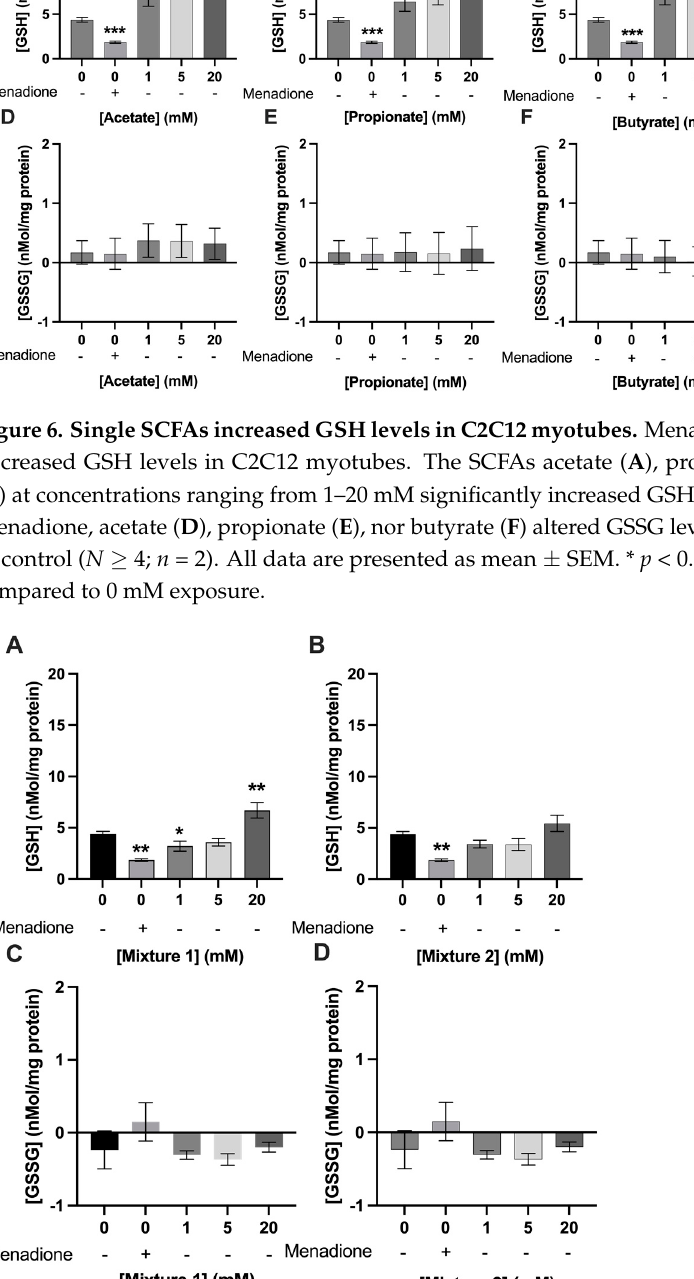
Figure 7. 20 mM of mixture 1 increased GSH levels while 1 mM decreased GSH in C2C12 myo ‐ tubes. Menadione (25 μ M) significantly decreased GSH levels in C2C12 myotubes. Twenty four hours of exposure to mixture 1 at 20 mM increased GSH levels in C2C12 myotubes ( A ), while 1 mM decreased GSH levels compared to 0 mM exposure. Mixture 2 did not change GSH or GSSG levels in C2C12 myotubes ( B ). Menadione, mixture 1 ( C ), nor mixture 2 ( D ) altered GSSG levels significantly compared to control ( N ≥ 3, n = 2). All data are presented as mean ± SEM. * p < 0.05; ** p < 0.001 compared to 0 mM